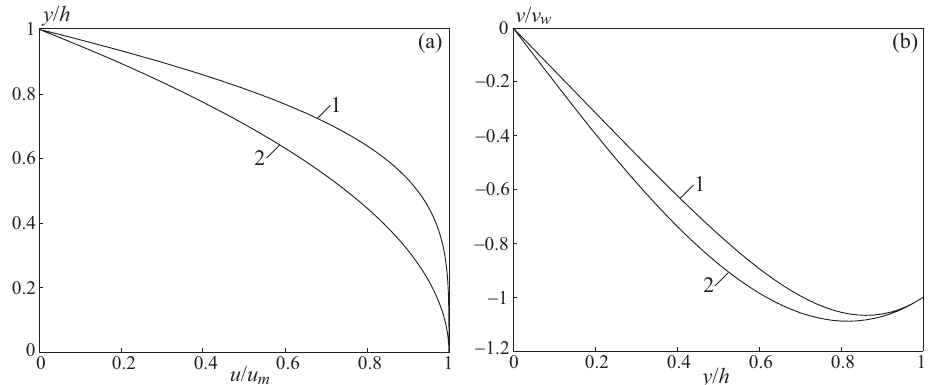
Figure 3. Profiles of axial velocity ( a ) and radial velocity ( b ) in a channel. Lines 1 and 2 correspond to the velocity profiles in channels with weak (Re → 0) and strong (Re → ∞ ) injection. Particles are non-deformable spheres of the same diameter; their collisions and their effect on the fluid are neglected. In the model of interaction between a particle and a carrier flow, the drag force and gravity force are taken into account. The drag coefficient of a particle is found from the Stokes law.